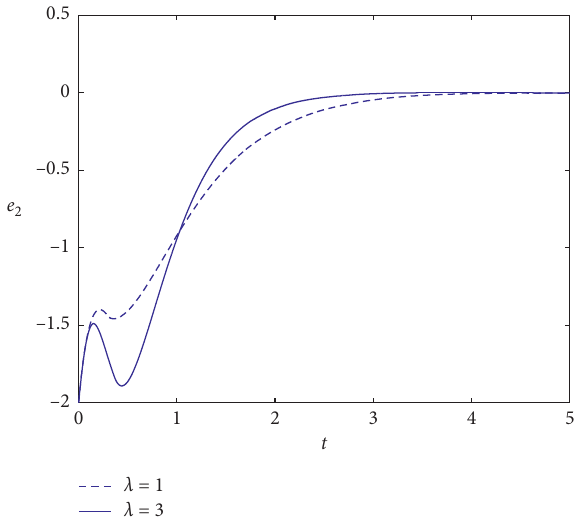
Figure 4: The time response of synchronization error variable e